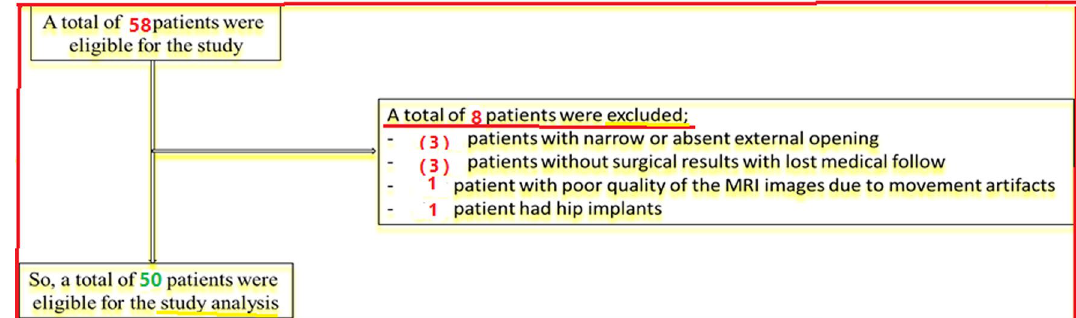
Fig. 1 Number of included and excluded patients